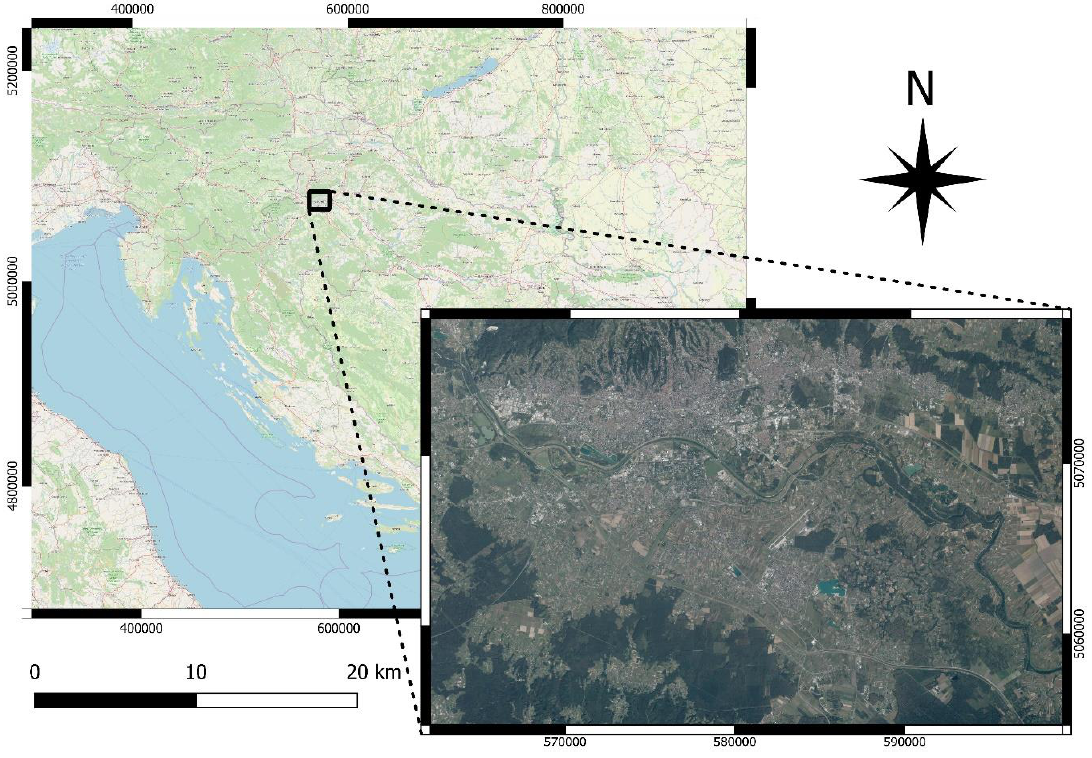
Figure 1. Study area location.